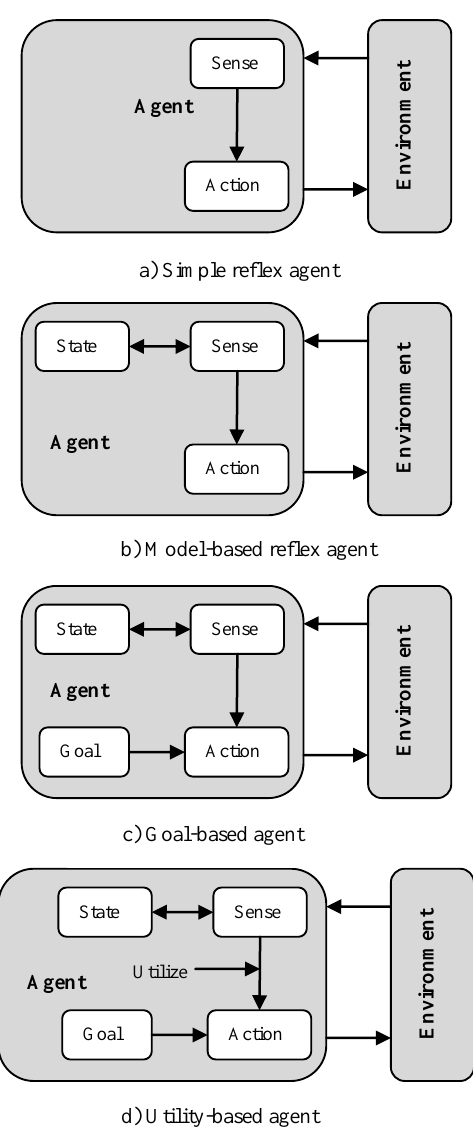
Figure 1. Four basic types of agent programs